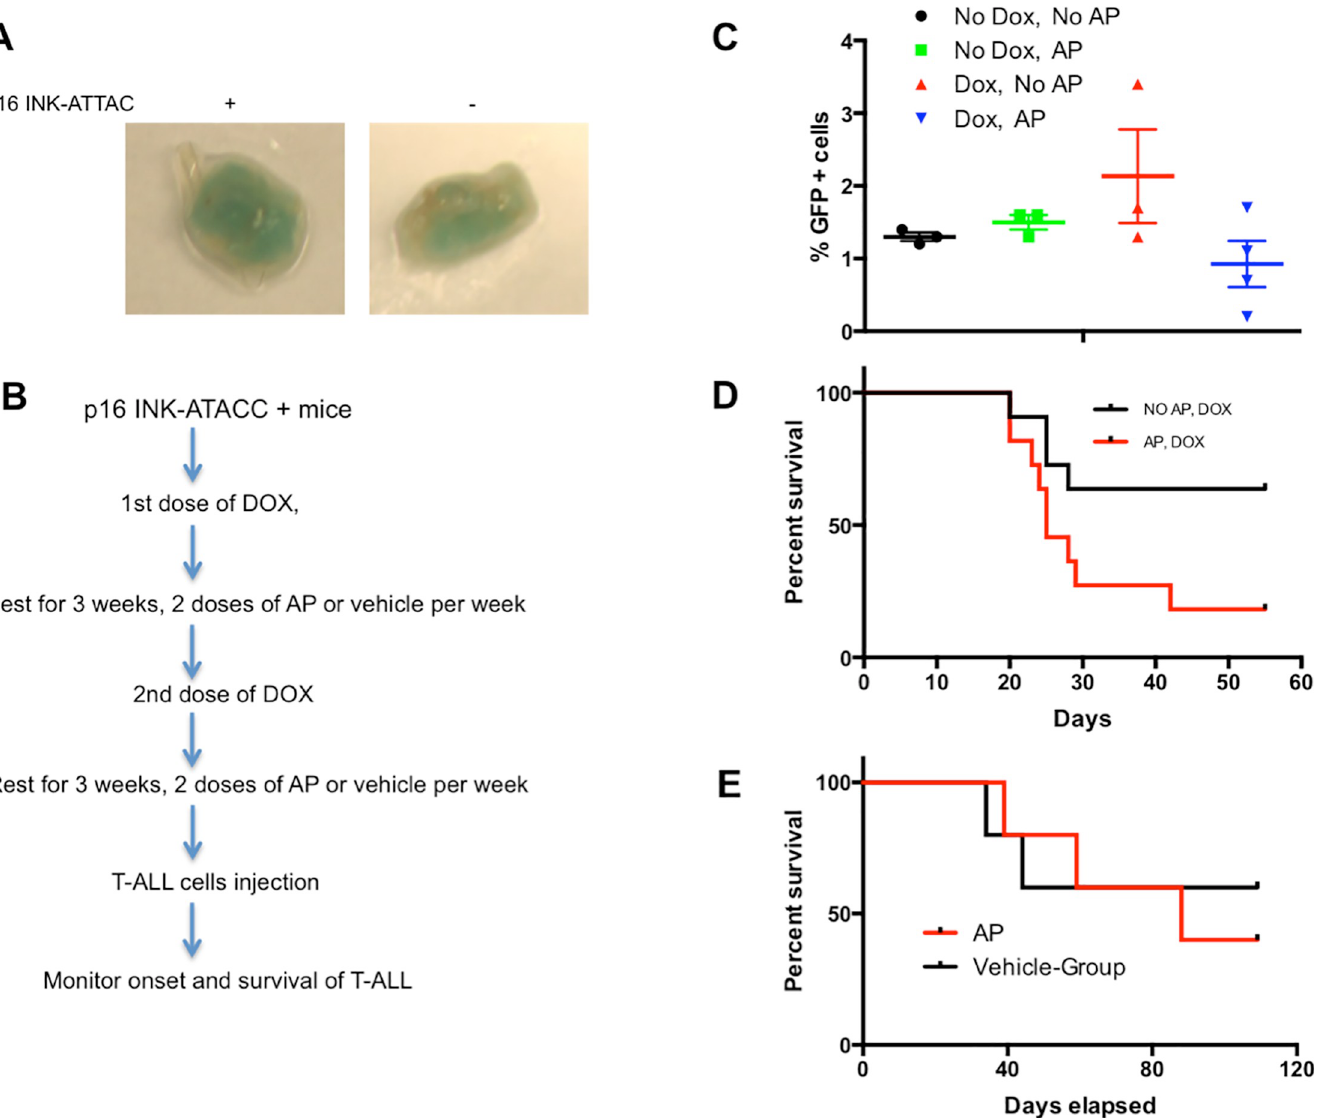
Fig 3. Clearance of chemo-induced senescent cell accelerated the development of T-ALL in p16 INK-ATACC mice. (A) SA- β -Gal stained IAT collected from 10- month-old p16 INK-ATTAC+ (left) and p16 INK-ATTAC- (right) mice. Both mice received AP20187. (B) Schematic of experimental procedures for (C) and (D). (C) Senescent (GFP+) cells were observed in peripheral blood on day 5 after the 2 nd dose of doxorubicin (10 mg/kg) followed by the treatment plan indicated in Fig 3B. Each group had 3 female mice. (D) Kaplan-Meier survival curve of p16 INK-ATTAC+ mice receiving doxorubicin and AP (2.5 mg/kg). The 1 st cohort (Black line, NO AP, DOX) received doxorubicin only (n = 11); the 2 nd cohort (Red line, AP, DOX) received both doxorubicin and AP20187 (n = 11). Log-rank (Mantel-Cox)